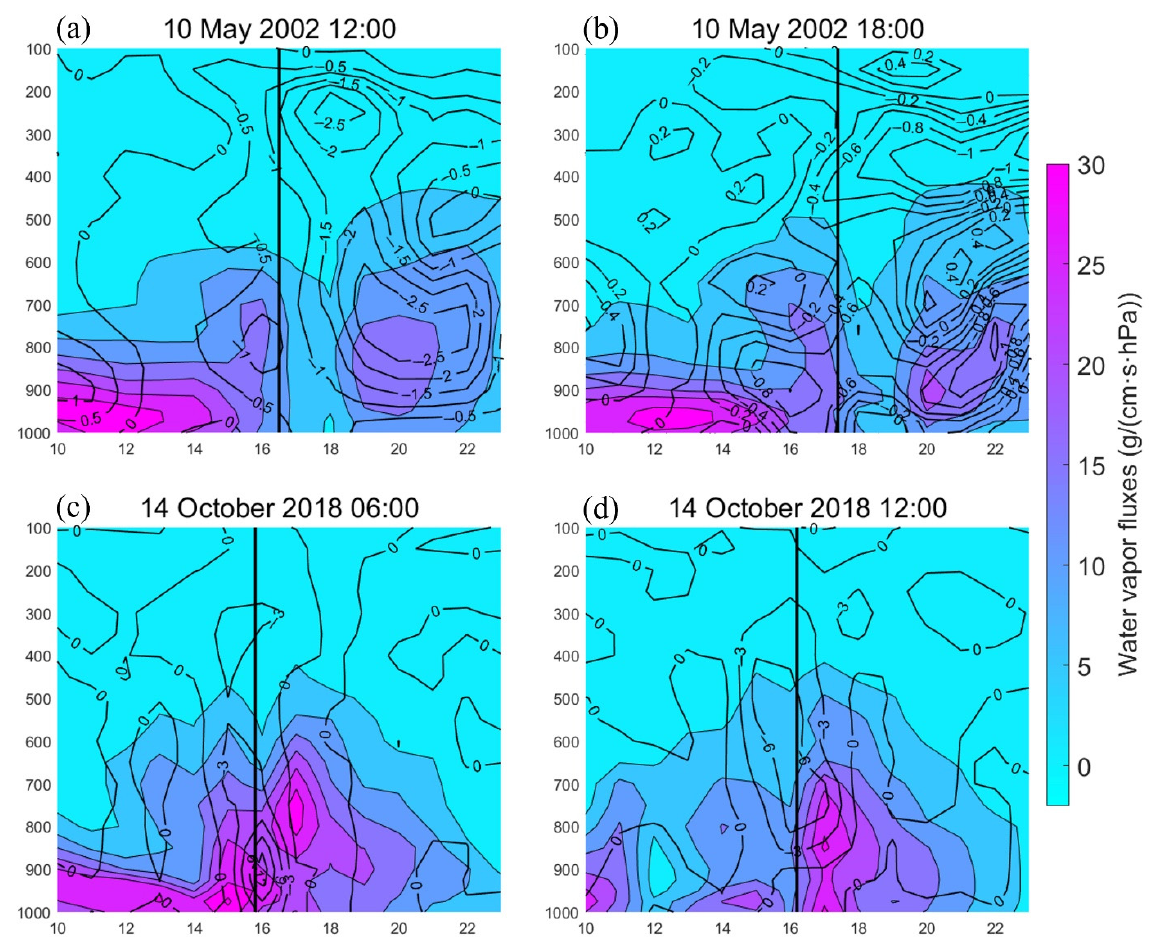
Figure 12. Zonal profiles of WVF and vertical velocity during and after landfall of ARB 01 ( a , b ) and Luban ( c , d ), where background colors indicate WVF. Black contour lines indicate vertical velocity. For Luban, during landfall in the zonal direction (Figure 12c), the vertical movement of the atmosphere is close to the TC center, the rising height is insufficient, and the height is below 600 hPa. In the meridional direction (Figure 13c), the WVF is concentrated on the east side of the TC center near the ocean, and the vertical movement is offset between 600–800 hPa. After landfall, in the zonal direction (Figure 12d), the WVF tends to the north side of the TC center, but the vertical movement tends to the south side of the TC center from low to high. In the meridian direction (Figure 13d), the WVF on the east side of the TC center is noticeably stronger than that on the west side, but the vertical movement of water vapor on the west side of the TC center rises higher and then tends to the east side. The combination of vertical motion and poor WVF results in no heavy precipitation in the